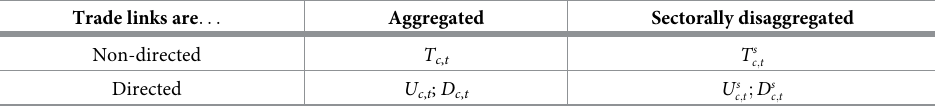
Table 2. Various explanatory variables and models applied to estimate shock contagion. Trade links are ... Aggregated Sectorally